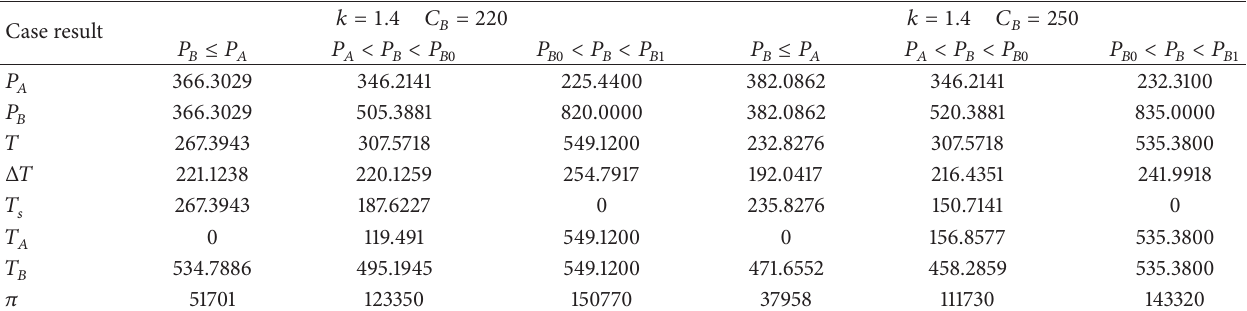
Table 5: The effect of RP cost changing in Stackelberg-merger model ( 𝑘 = 1.4